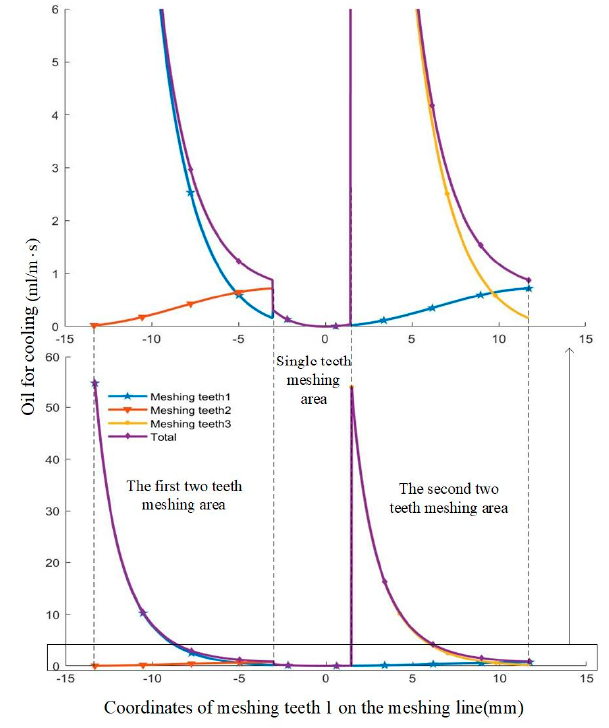
Figure 5. Oil volume for cooling during the meshing process.